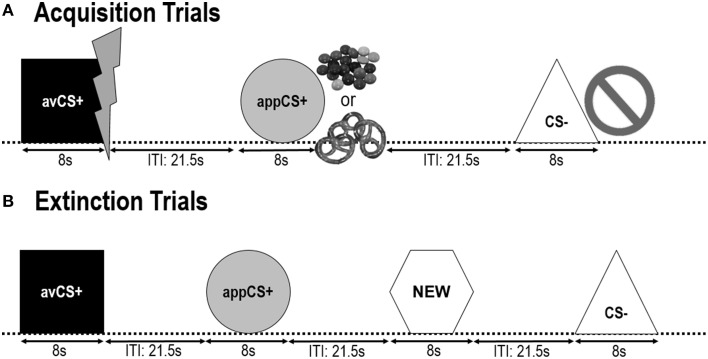
Trials during the two acquisition phases (A) and the extinction phase (B). Participants learned that one shape (avCS+) predicted a mild painful electric shock, one shape (appCS+) predicted either a piece of chocolate or a small salty pretzel (according to their preference), and a third shape (CS–) did not predict any biologically salient event. Each shape was presented in conjunction with a picture depicting an electric shock, smarties/salty pretzel, or nothing depending on the association with the US. During the extinction phase, the three geometrical shapes were presented once again, but no USs were delivered. In addition, a fourth geometrical shape (NEW) was presented as a neutral control.